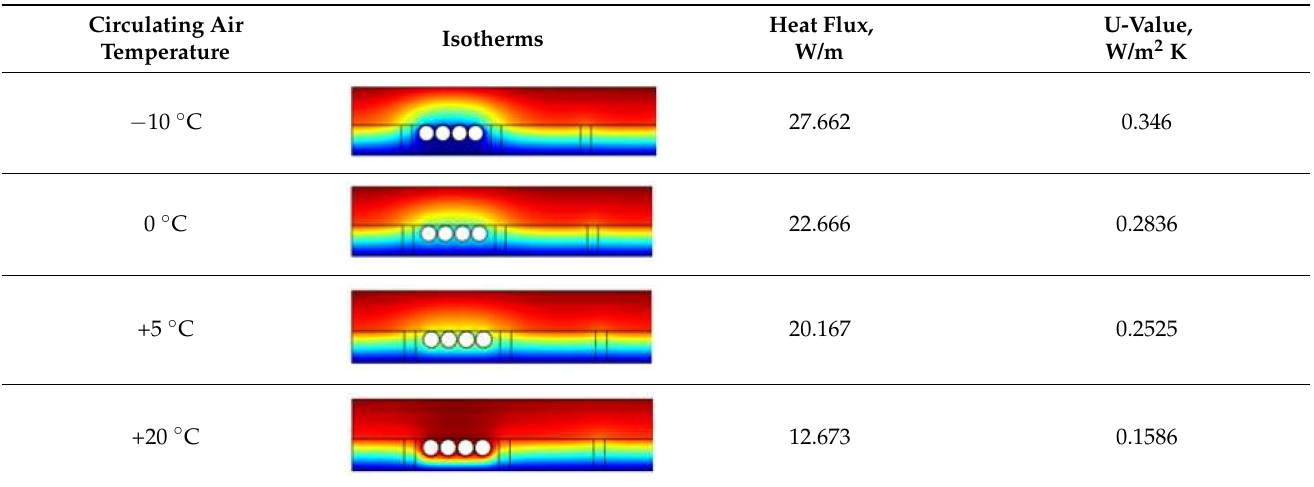
Table 4. Effect of circulating air temperature on heat losses.